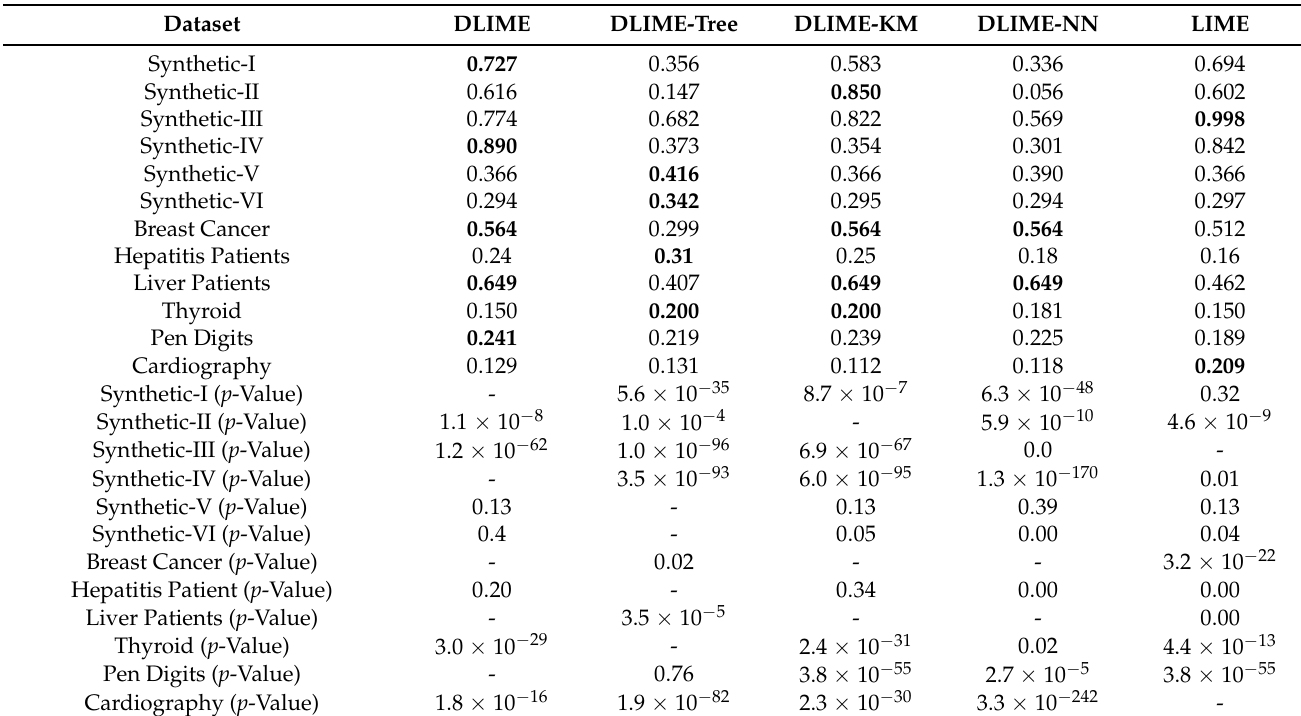
Table 4. Quality of explanations for all datasets (higher is better) and dataset wise statistical significance between best performing model and other models (lower is